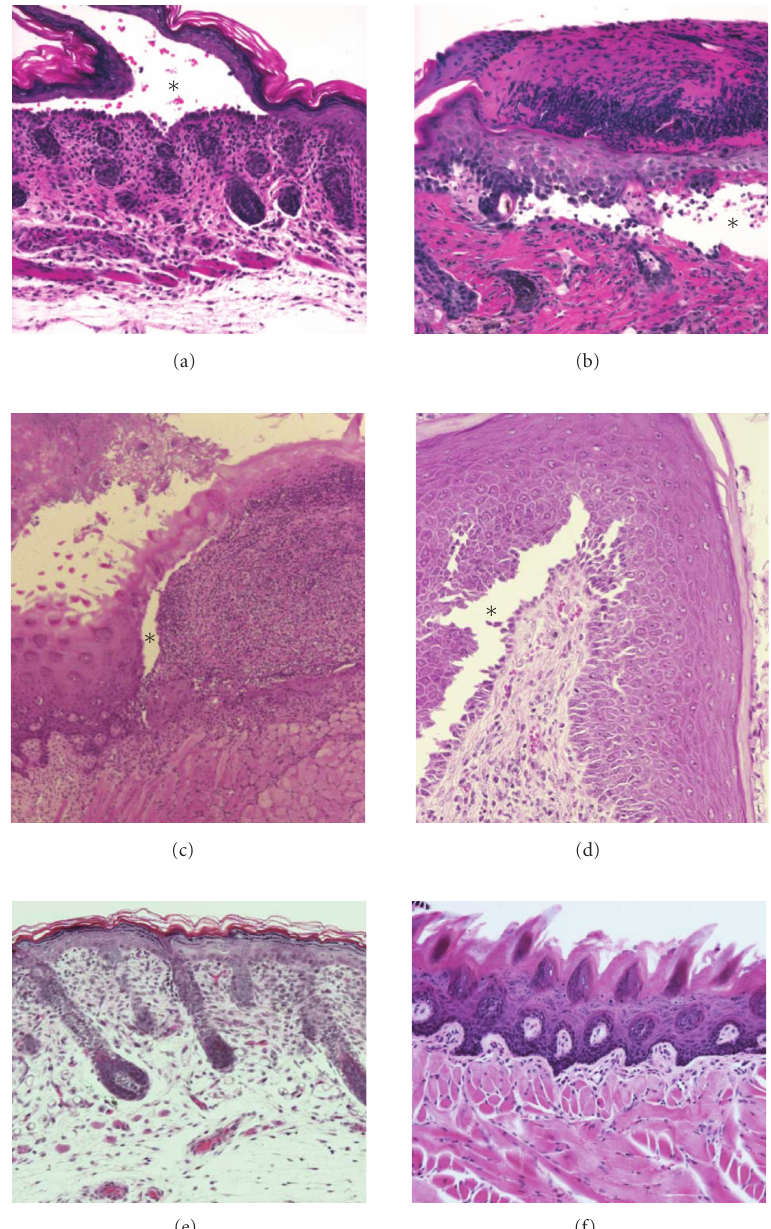
Figure 2: Acantholysis in the interfollicular epidermis and mucous membranes of Dsc3 and Dsg3 null epithelia. (a) Acantholysis between the basal and first suprabasal layer in the back skin epidermis of newborn conditional Dsc3 null mice ( Dsc3 fl/fl /K14-Cre). (b) Severe skin lesions of a 140 day-old Dsc3 fl/fl /K14-Cre mouse showing blistering in a healing wound. Note that these mice enter a cycle in which acantholysis triggers epithelial tongue formation and secondary blistering in the epithelium that covers the original wound. (c) Tongue section from a 25-day-old Dsg3 null mouse showing acantholysis and massive inflammation in the epithelium. (d) Vagina of a 6-month-old Dsg3 null mouse showing acantholysis in the deep epithelium (between basal and suprabasal layer). (e) Back skin of an adult wild type mouse. (f) Tongue histology of an adult wild type mouse. Stars indicate blister